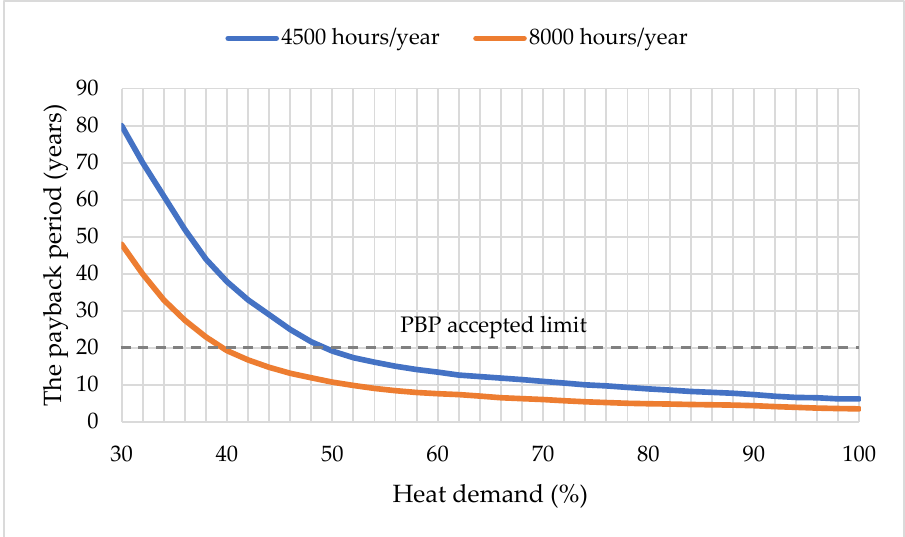
Figure 8. The payback period depending on the heat demand.